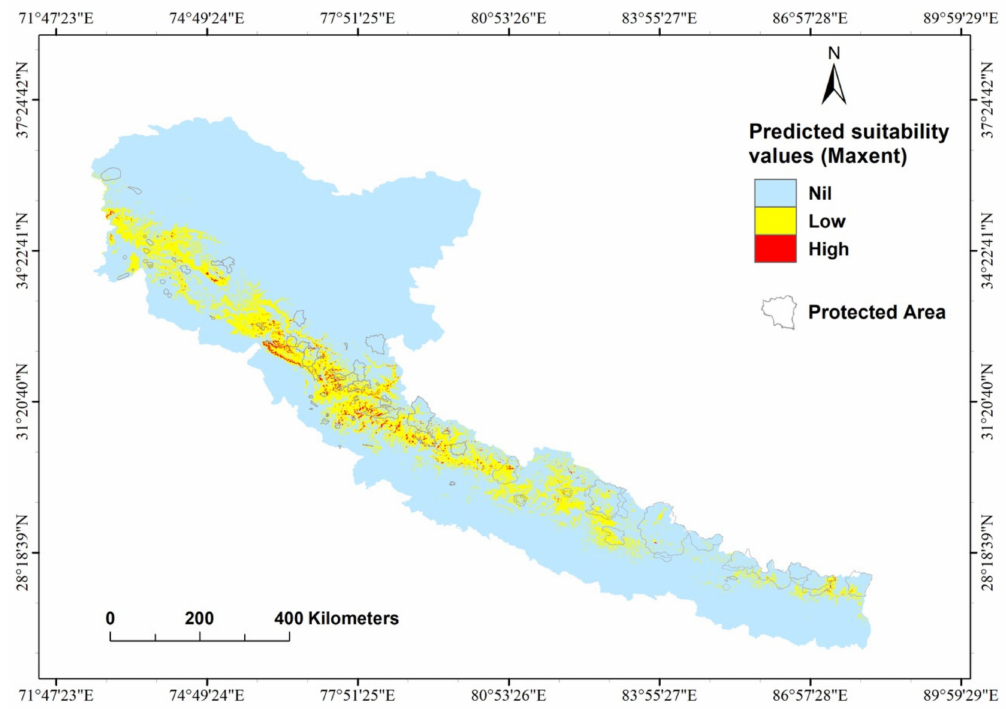
Figure 6. Protected areas map overlaid with the suitable habitat of the cheer pheasant.